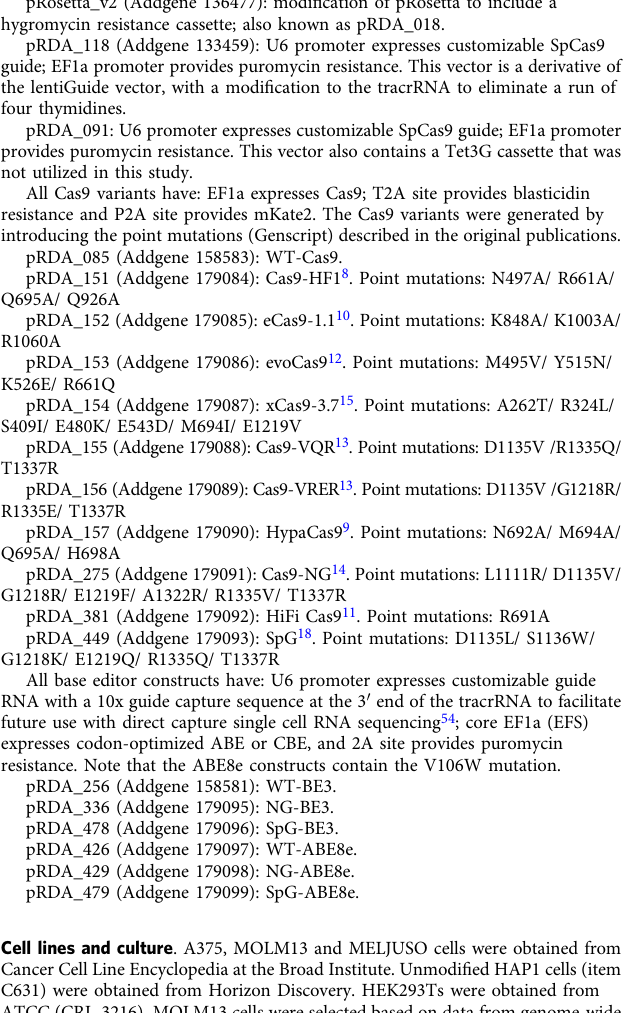
Fig. 7 Venetoclax-resistant BCL2 mutants identi fi ed by base editing with Cas9-NG. a Timeline by which tiling screens were conducted. b Performance of sgRNAs targeting BCL2 for the Venetoclax-treated arm, plotting both CBE and ABE screens, colored according to the predicted mutation bin. A dashed line delineates the z-score cutoff of 3. Boxes show the quartiles (Q1 and Q3) as minima and maxima and the center represents the mean; whiskers show 1.5 times the interquartile range (Q1-1.5*IQR and Q3 + 1.5*IQR). Categories with n < 20 are shown as individual dots. c 3D structure of BCL2 in complex with Venetoclax (PDB ID: 6O0K). Amino acids that sg19 – 23 are predicted to edit are highlighted in pink. d Translated sequence around sg20 for any allele